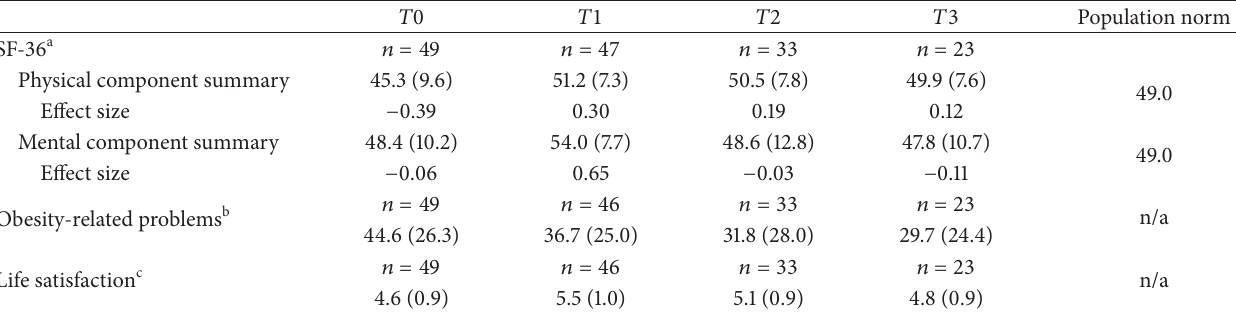
Table 4: Mean and standard deviation of quality of life outcomes during the two-year lifestyle intervention for severely obese adults. 𝑇0 𝑇1 𝑇2 𝑇3 SF-36 a 𝑛 = 49 𝑛 = 47 𝑛 = 33 𝑛 =